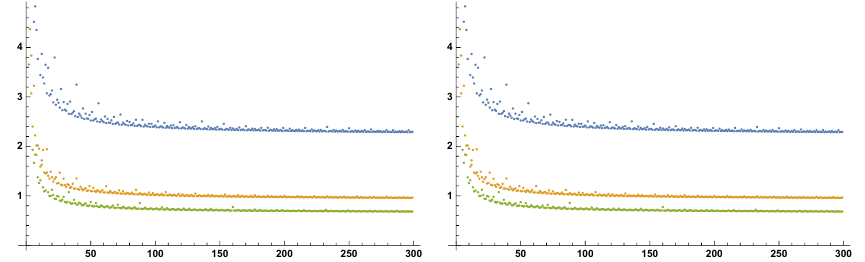
Figure 5. Solutions of C D β u + u = u p + 1 (on the left ) and of C D β u = u − u ( p + 1 ) (on the right ) with β = 1/2 and u 0 = 1/2,1/3,1/4,1/5 and p = 1,2. Darker lines correspond to bigger u 0 ’s; continuous lines correspond to p = 2 and dashed lines correspond to p = 1.